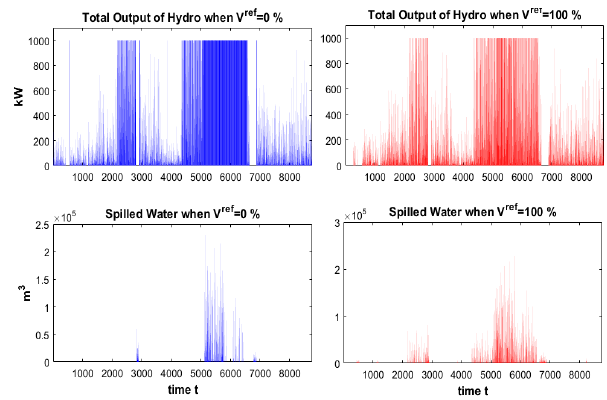
Figure 11. HPP Operation Results Under V ref = 0% and 100%.